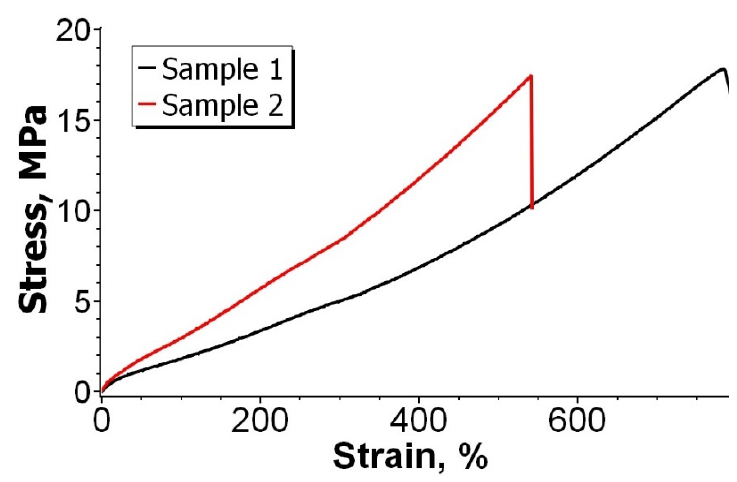
Figure 5. Stress-strain curve of the tensile